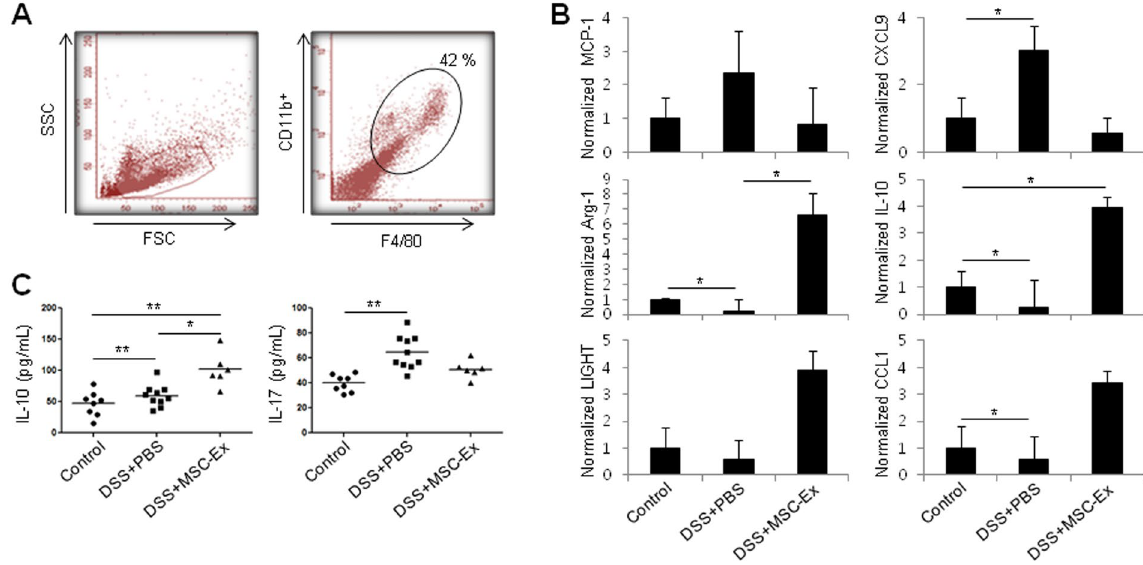
Figure 5. Phenotype shift of peritoneal macrophages by MSC-Ex. (A) F4/80 + /CD11b + macrophage cells were isolated by flow cytometry from the peritoneum of acute colitis-induced mice. (B) The relative expressions of MCP-1 (M1 marker), CXCL9 (M1 marker), Arg-1 (M2 marker), IL-10 (M2 marker), LIGHT (M2 marker), and CCL1 (M2 marker) in F4/80 + /CD11b + peritoneal macrophage cells were examined by qRT-PCR analysis. (C) IL-17 (left) and IL-10 (right) levels in the colonic tissues were determined by ELISA. Data are represented as the means ± s.d. ( n > 3 ). * P < 0.05, ** P < 0.005, *** P < 0.001